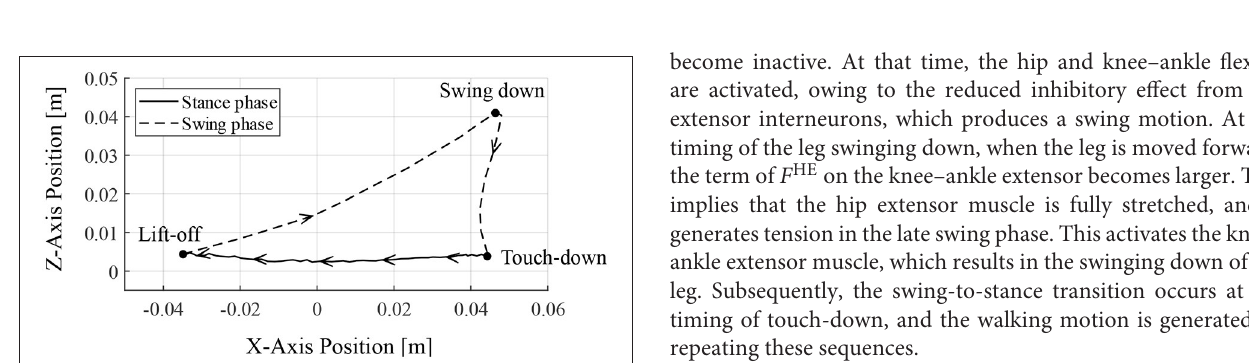
FIGURE 8 | Gait diagram. RF, LF, RH, and LH represent the right–fore leg, left–fore leg, right–hind leg, and left–hind leg, respectively, and the colored regions indicate ground contact.